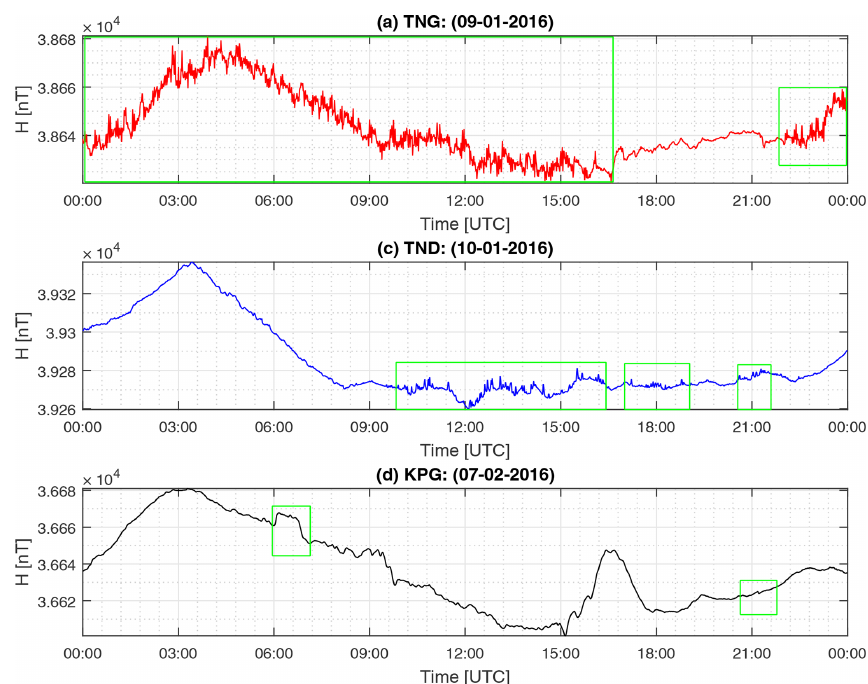
Figure 5. Example artificial disturbance (or “noise”) in Indonesian observatory data during 2016. Data are the computed minute-mean values. The green boxes indicate the periods of disturbance.